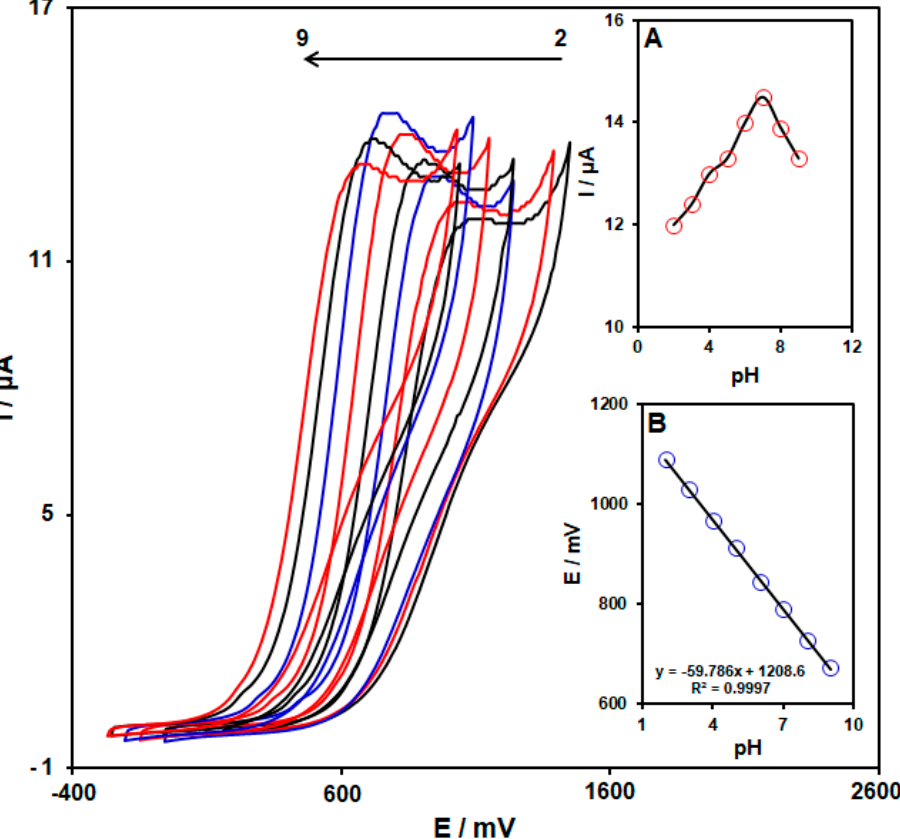
Figure 4. CV response of 100.0 µ M hydroxylamine on the PPy NTs/GSPE in 0.1 M PBS at different pH values (2.0–9.0). ( A ) Plot of the oxidation peak current of hydroxylamine as a function of the pH solution. ( B ) Plot of the oxidation peak potential of hydroxylamine as a function of the pH solution.